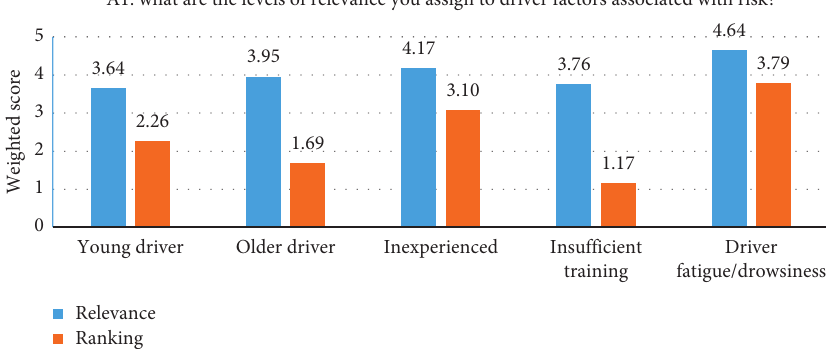
Figure 2: Weighted mean of relevance and priority ranking related to Question A1.